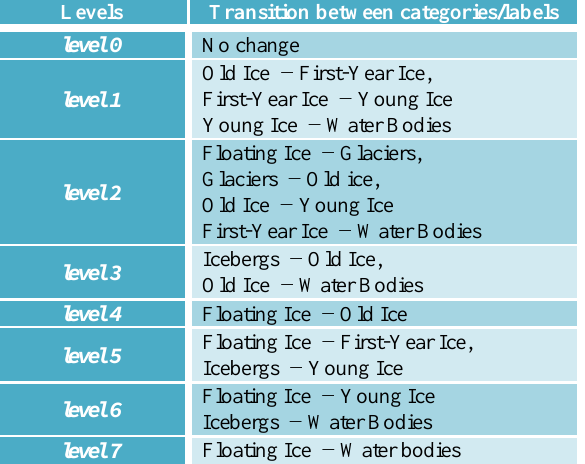
Table 2. Different levels of change.